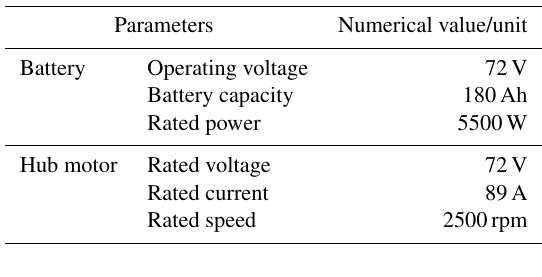
Table 2. Vehicle structure parameters.